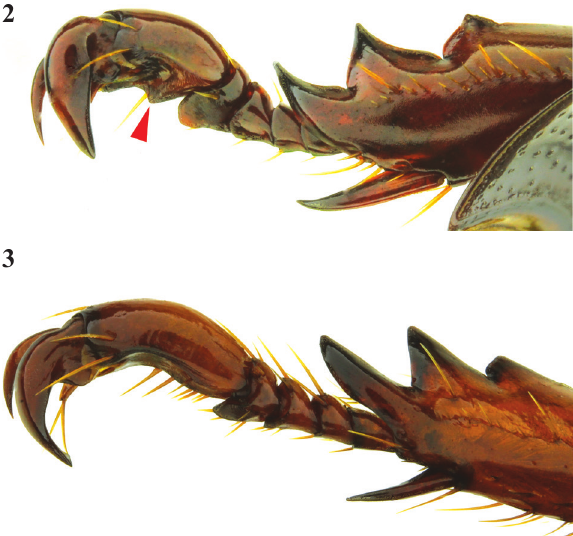
Figures 2, 3. Male protarsal large claw of (2) C. pantanalensis Rat- cliffe & Seidel, sp. nov. and (3) C. howdenorum Joly &